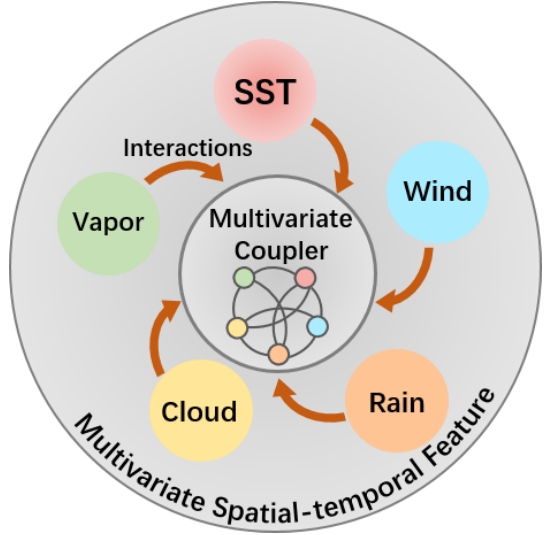
Figure 2. A description of our proposed multivariate air–sea cou- pler, which utilizes the spatial–temporal features of multiple physi- cal variables to simulate the energy exchanging